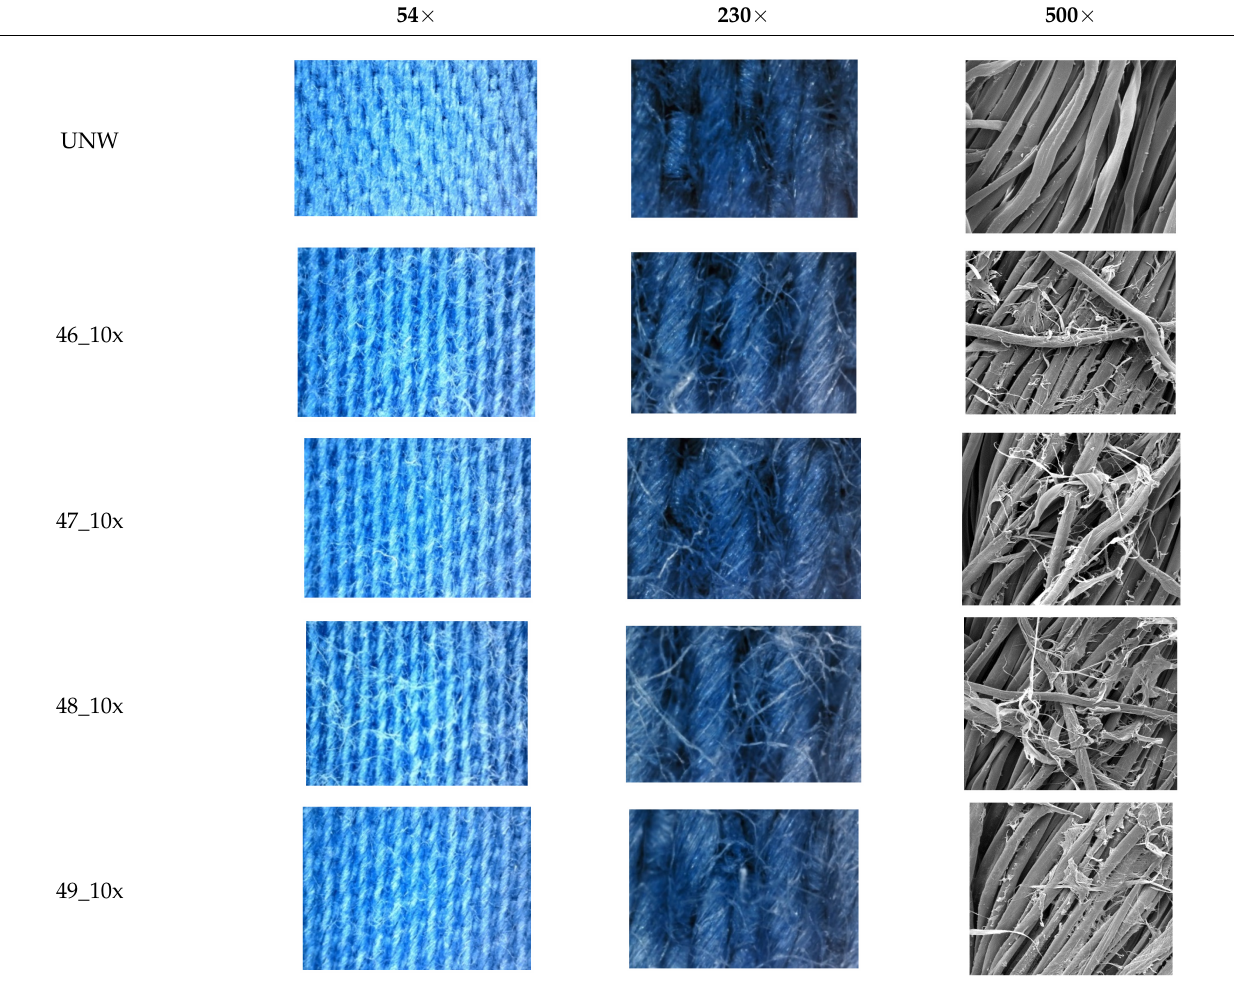
Table 10. Digital images of samples magnified 54 and 230 × and SEM image magnified 500 ×